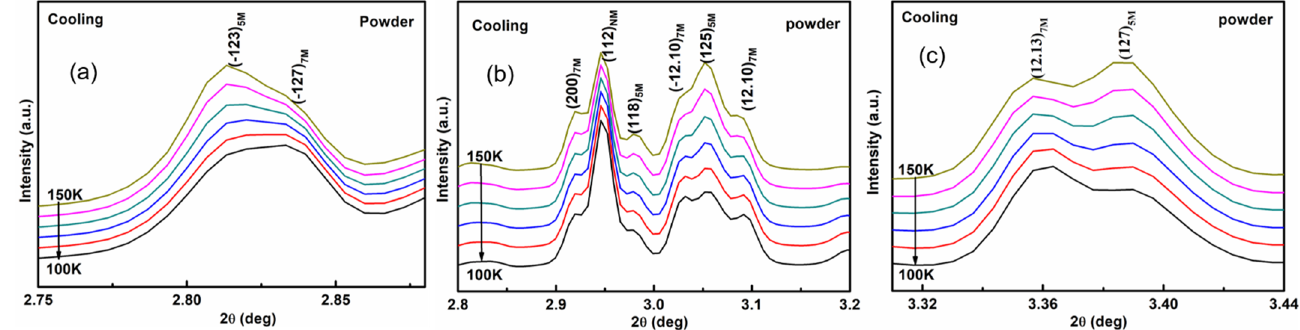
Figure 6. High-energy X-ray diffraction patterns around 2 θ = 2.8° ( a ), 2 θ = 3.0° ( b ), and 2 θ = 3.4° ( c ) collected during cooling from 150 K to 100 K for the Ga22-4 ( x = 5.5) alloy.